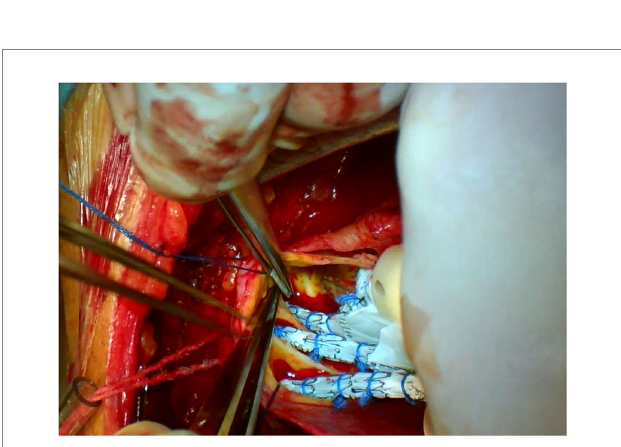
FIGURE 6 Partial upper sternotomy incision for total arch repair of acute type A aortic